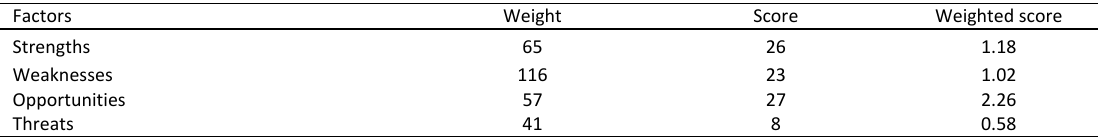
Table 6: Factors analysis of Tehran